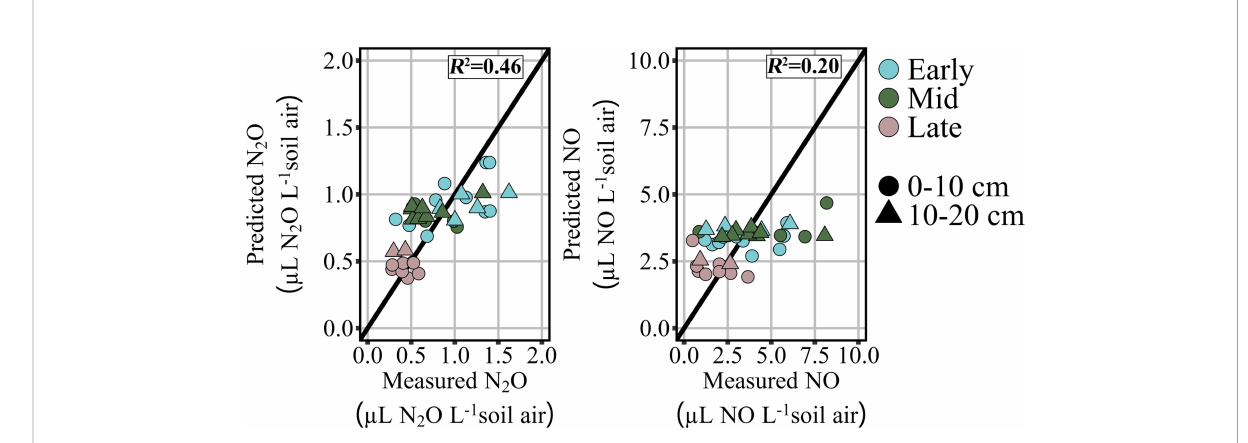
FIGURE 5 Least absolute shrinkage and selection operator (LASSO) regression model prediction of testing data for pore-space concentration of nitrous oxide (µL N 2 O L -1 soil air) and pore-space concentration of nitric oxide (µL NO L -1 soil